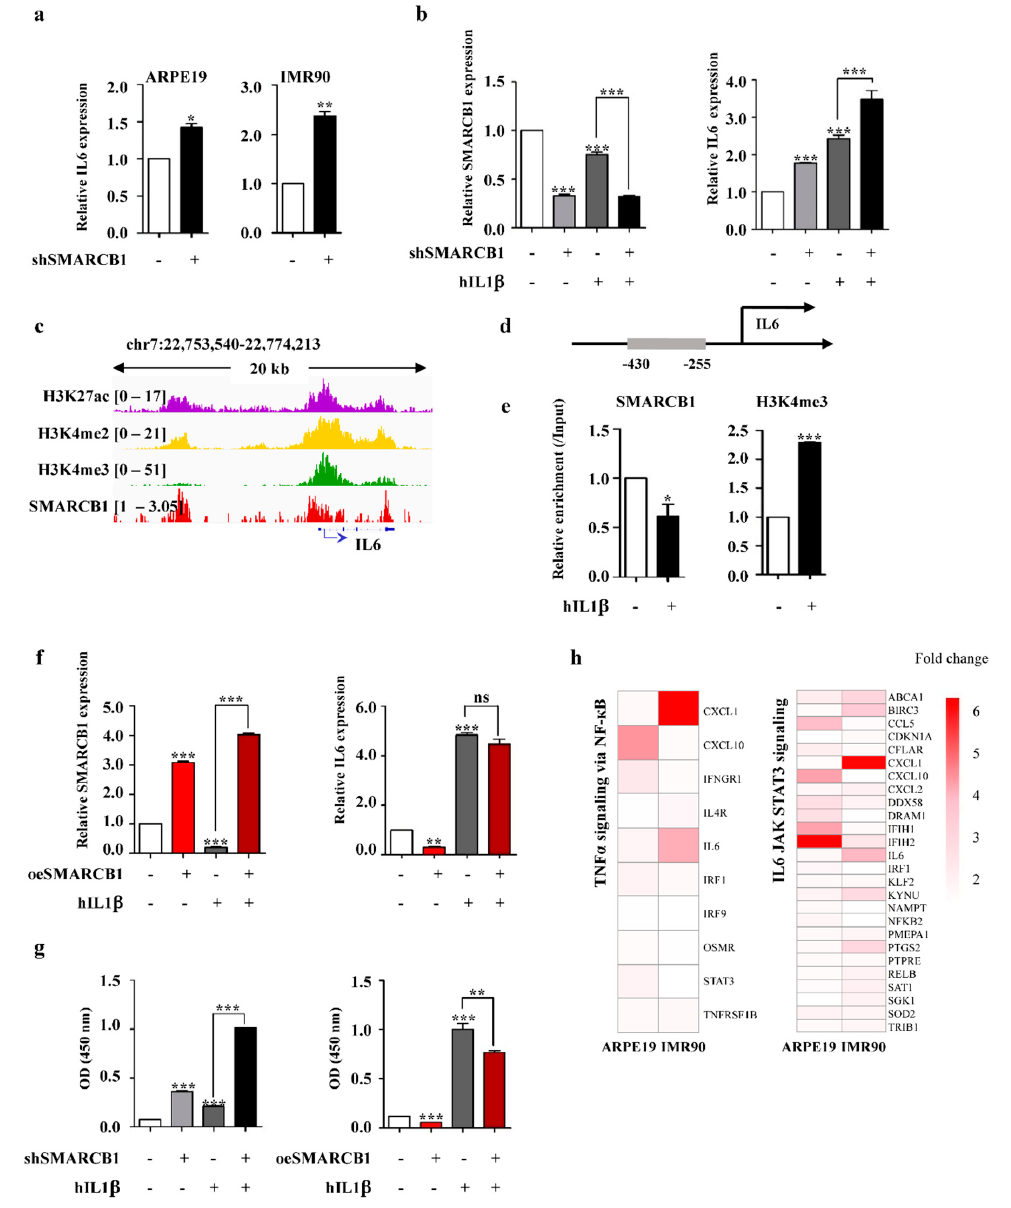
Figure 4. SMARCB1 directly regulates IL6. ( a ) mRNA level of IL6 determined by real-time PCR in SMARCB1 knockdown ARPE19 and IMR90. We performed three independent experiments and analyzed statistically (mean +/- S.E.M, Statistical significance * p < 0.05, ** p < 0.01 vs shControl). ( b )